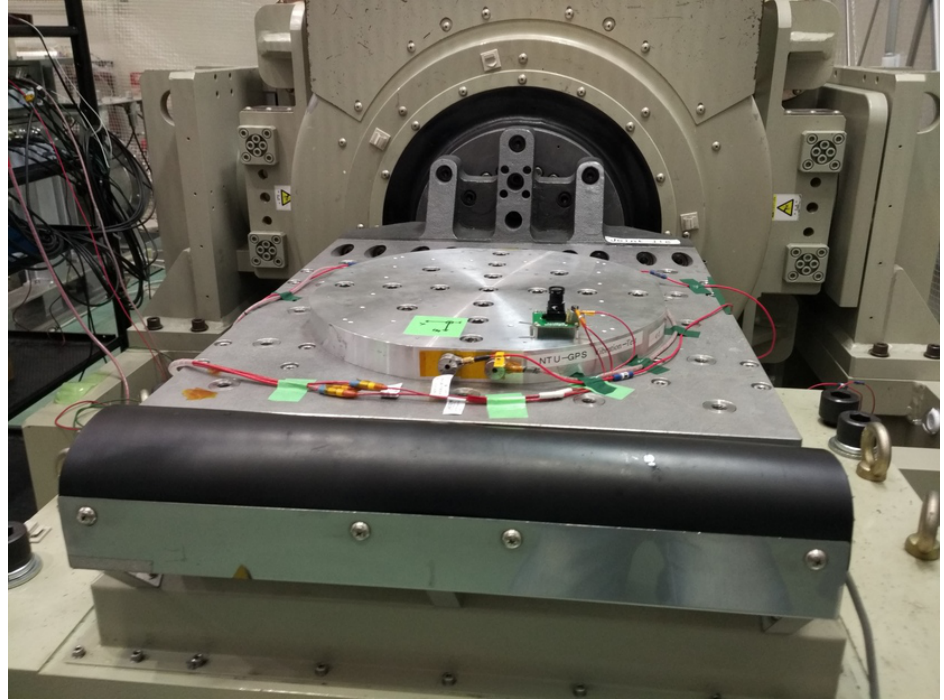
Figure 7. Camera module undergoing vibration